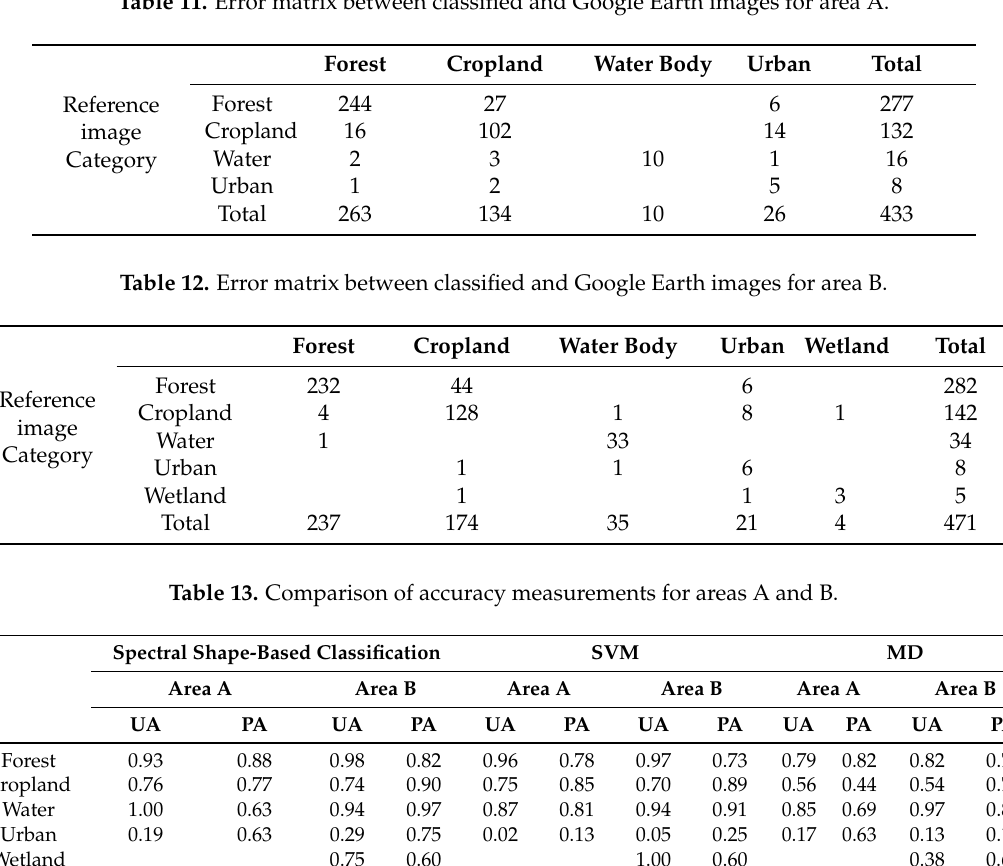
Table 11. Error matrix between classified and Google Earth images for area A.